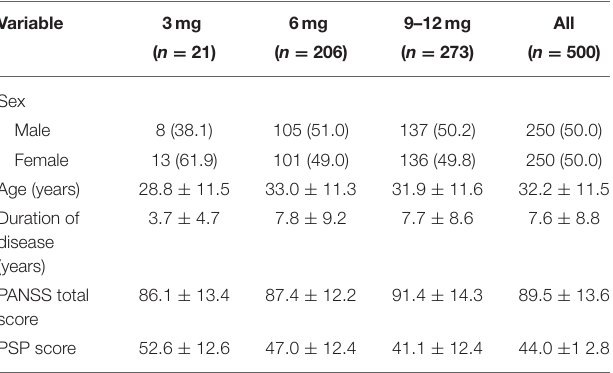
TABLE 1 | Baseline characteristics of the participants. TABLE 2 | Anti-EPS drug* combination during the study in each